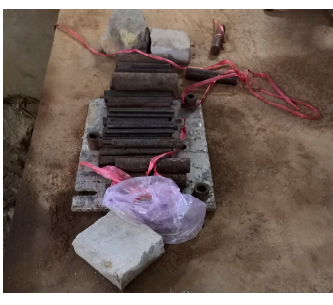
Figure 20. Quickly obtained propagation speed of electromagnetic waves in this medium.